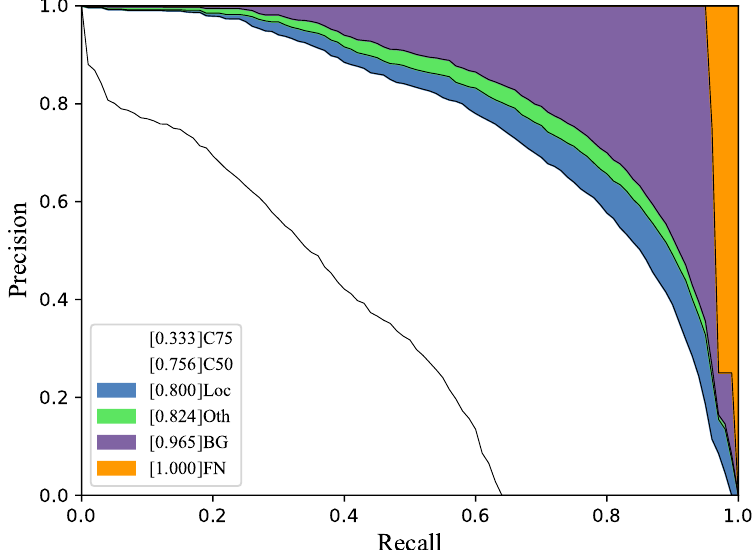
Figure 8. Error analysis on URPC 2018. We decompose the error of our detector on the URPC2018 dataset and determine that the main error contribution is the BG error, which means the detector has difficulty finding the object in a severely degraded image. To this end, our work introduced a novel fine-grained FPN module and enhanced the feature representation of feeble and small